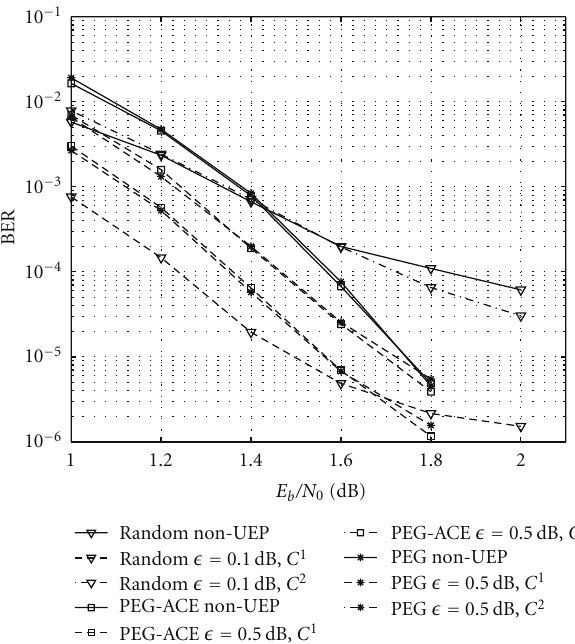
Figure 4: BER performance of non-UEP and UEP codes, con- structed by three di ff erent construction algorithms. All codes have n = 2048 and allowed d v max = 20. The random code has good UEP capability already for (cid:2) = 0 . 1 dB, while the PEG code and the PEG- ACE code have less UEP capability for (cid:2) = 0 . 5 dB. All UEP codes have better average performance than the corresponding non-UEP codes, except for the random code at low E b /N 0 .